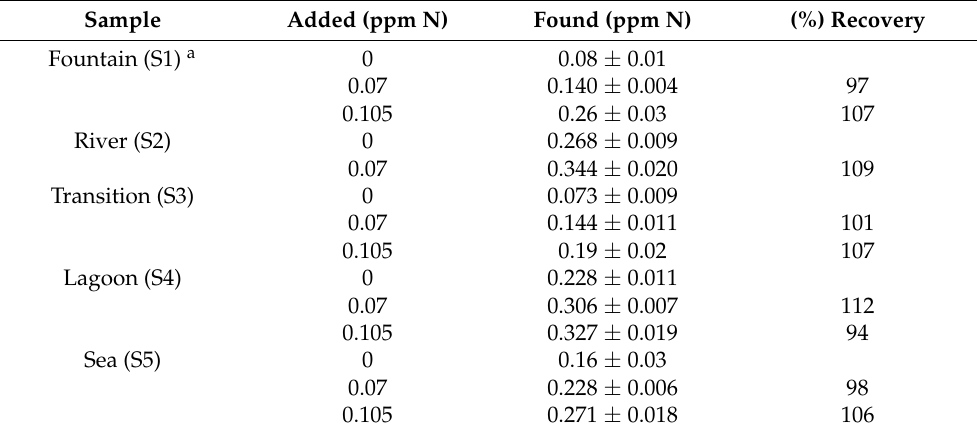
Table 4. Nitrogen found and recoveries in different water samples. a Processed in